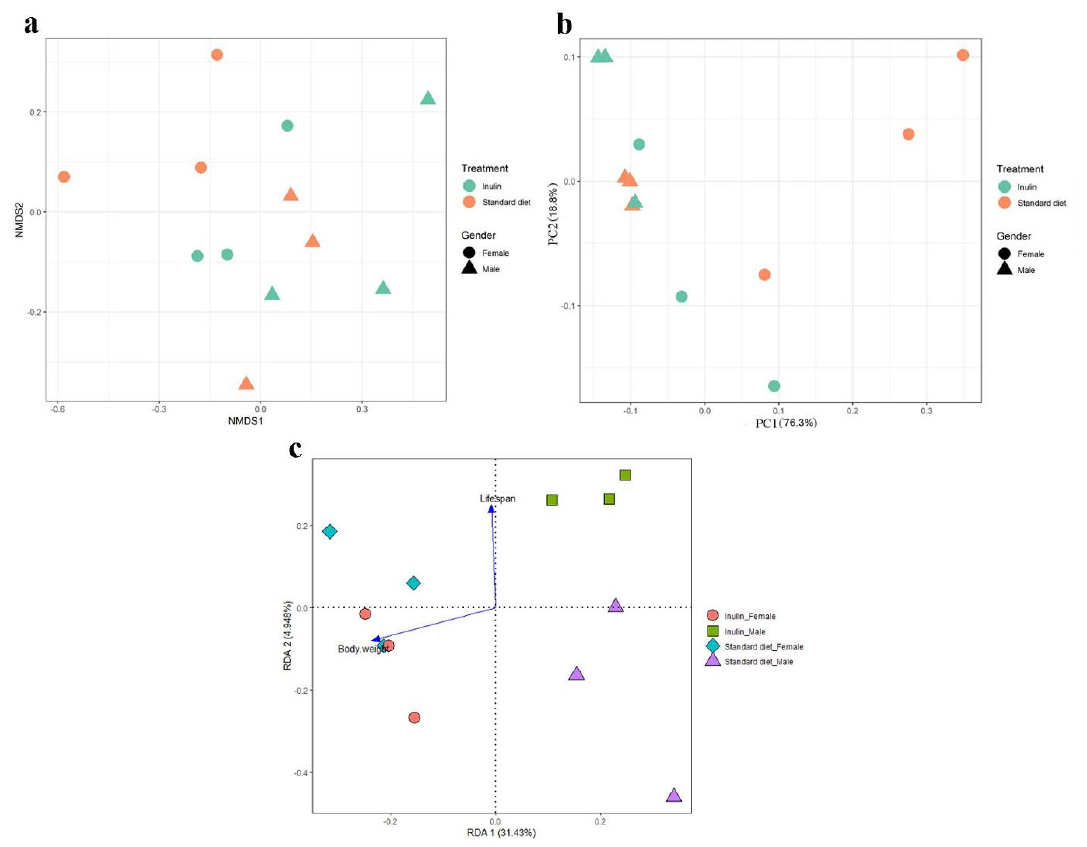
Figure 6. Nonmetric multidimensional scaling (NMDS) ( a ) principal coordinate analysis (PCoA) score plots ( b ) based on weighted UniFrac metrics and redundancy analysis (RDA) ( c